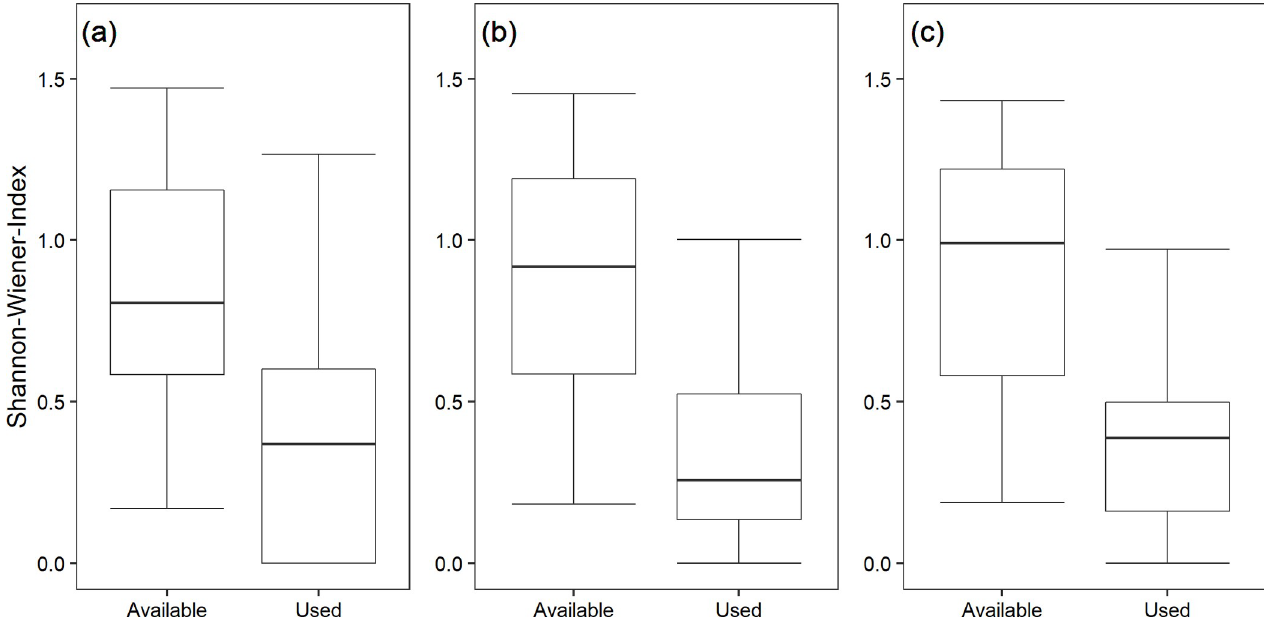
Fig 4. Habitat diversity available to and used by the grey partridge. Habitat diversity available to and used by the grey partridge in Vienna district for the years (a) 2001, (b) 2009, and (c) 2017. Habitat diversity was measured by the Shannon-Wiener-Index (medians with 25 th /75 th and 10 th /90 th percentiles) using the annual land cover map. See text for statistical details.